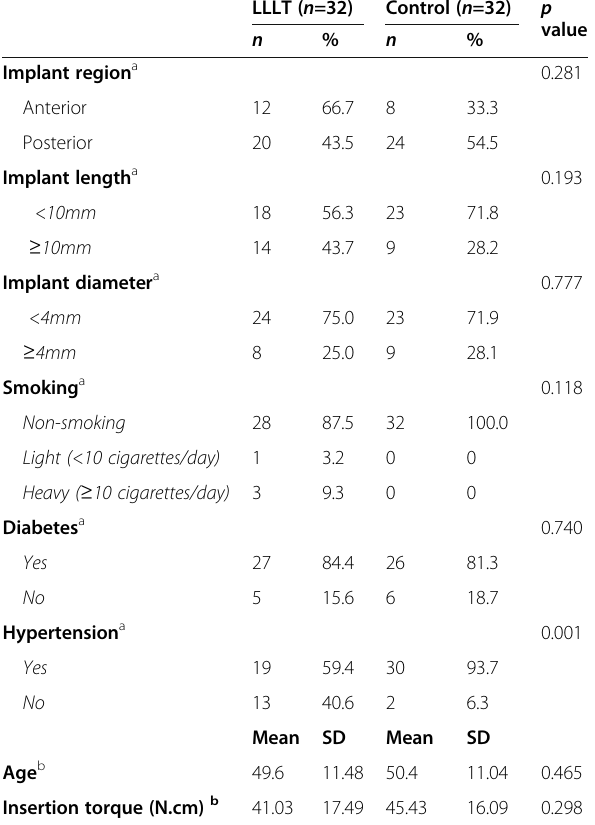
Table 1 Distribution of implant and patient ’ s characteristics considering LLLT and control groups